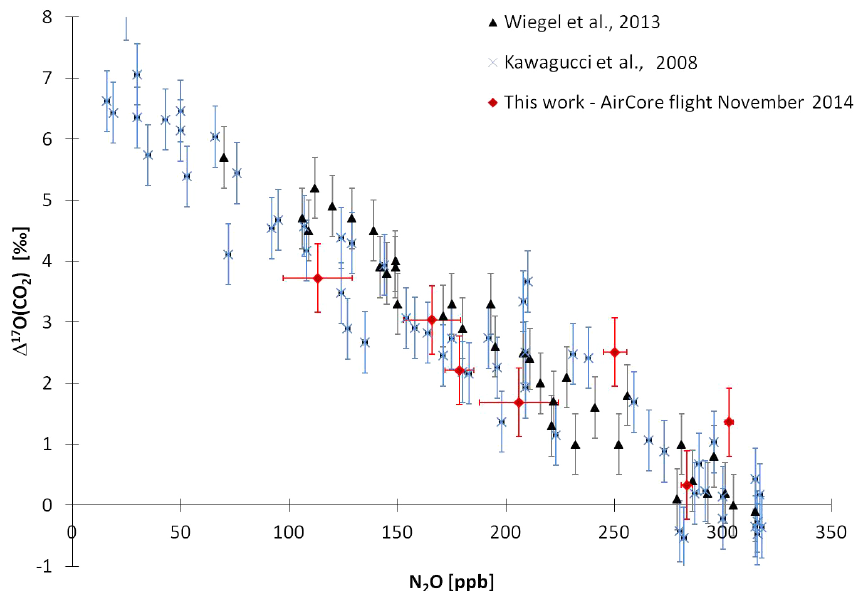
Figure 10. Comparison of the linear negative correlation between (cid:49) 17 O(CO 2 ) and N 2 O from measurements of the AirCore/SAS samples (red rhombuses) presented here with literature data from (Kawagucci et al., 2008) (blue crosses) and (Wiegel et al., 2013) (black triangles). For the AirCore dataset, N 2 O mole fractions were deduced from CH 4 mole fractions as described in the text. The horizontal error bars are a combination of the range of CH 4 mole fractions that is combined within a single SAS segment and the error of the CH 4 –N 2 O transfer function. The vertical error bars represent (cid:49) 17 O(CO 2 ) uncertainty of 0.56‰ (1 σ